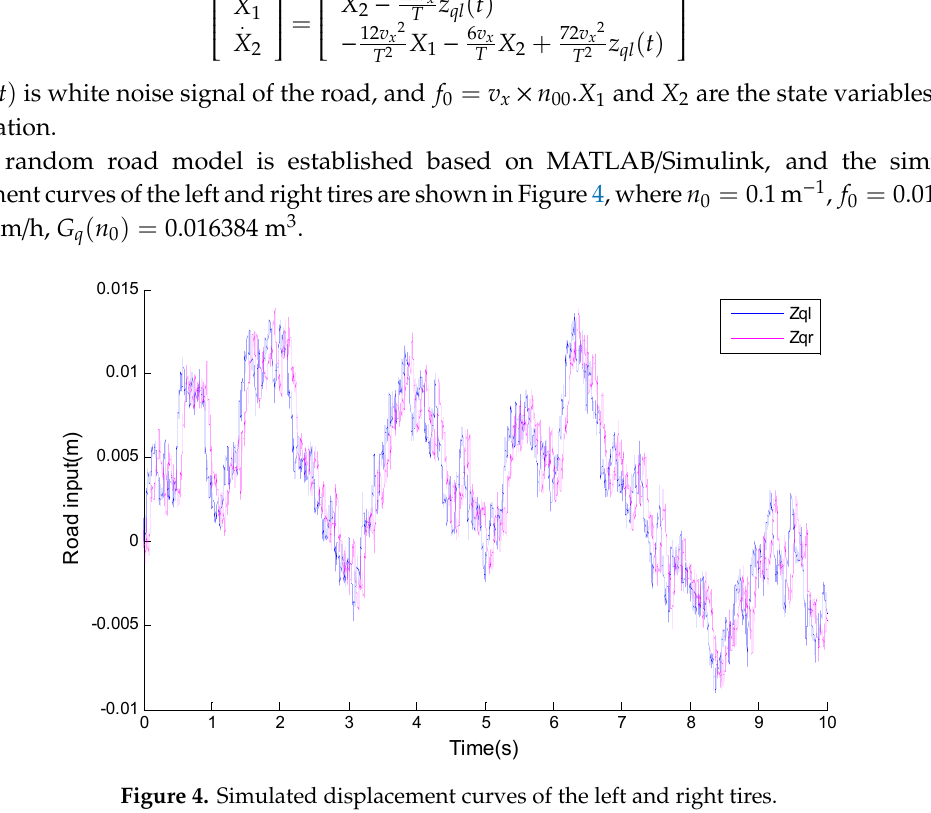
Figure 4. Simulated displacement curves of the left and right tires.